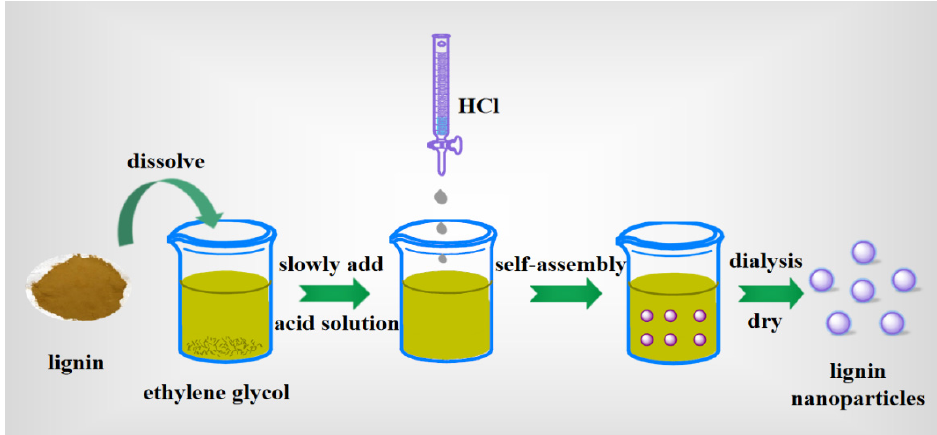
Figure 5. Synthesis of lignin nanoparticles by self-assembly in ethylene glycol using HCl as an-